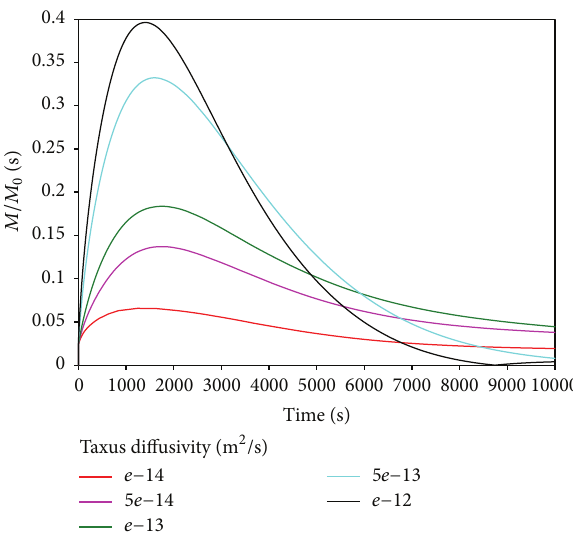
Figure 3: Influence of coating diffusivity on drug concentration into the artery wall.